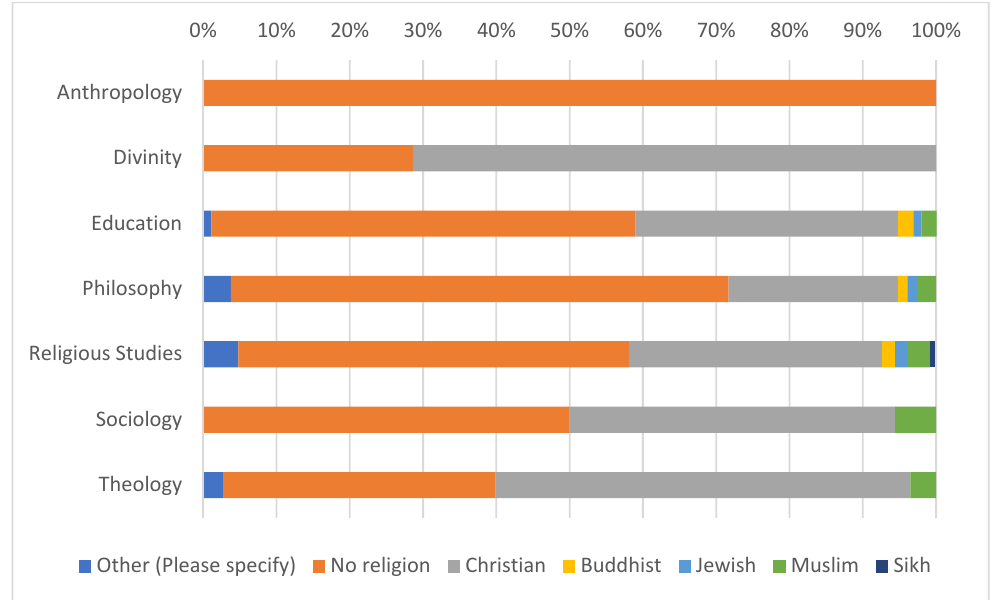
Figure 6. Q16 What is your religion? (England, Scotland and Secondary only): n = 346.